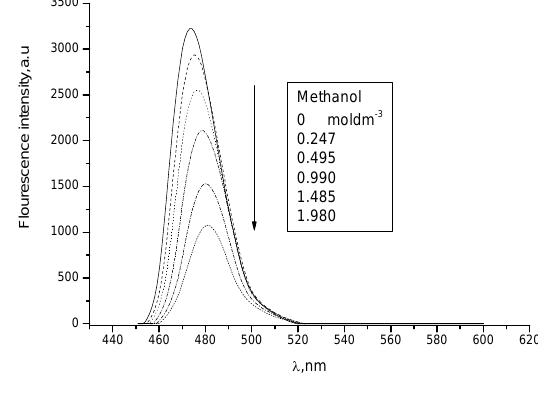
Figure 10. Quenching of 7 in chloroform by addition of polar methanol (0, 0.05, 0.1, 0.2, 0.3, 0.4